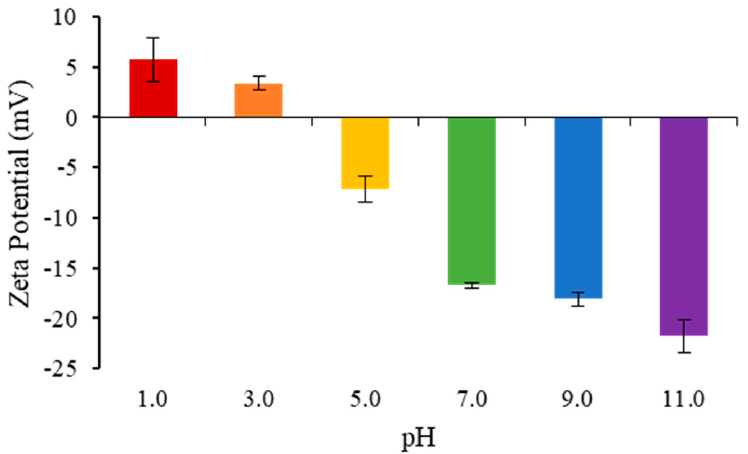
Figure 2. Zeta potential of GQDs-hMSNs (32 µ g/mL) in various pHs (maleate 1.0, citrate 3.0–5.0, HEPES 7.0, CHES 9.0, and CAPS 11.0).